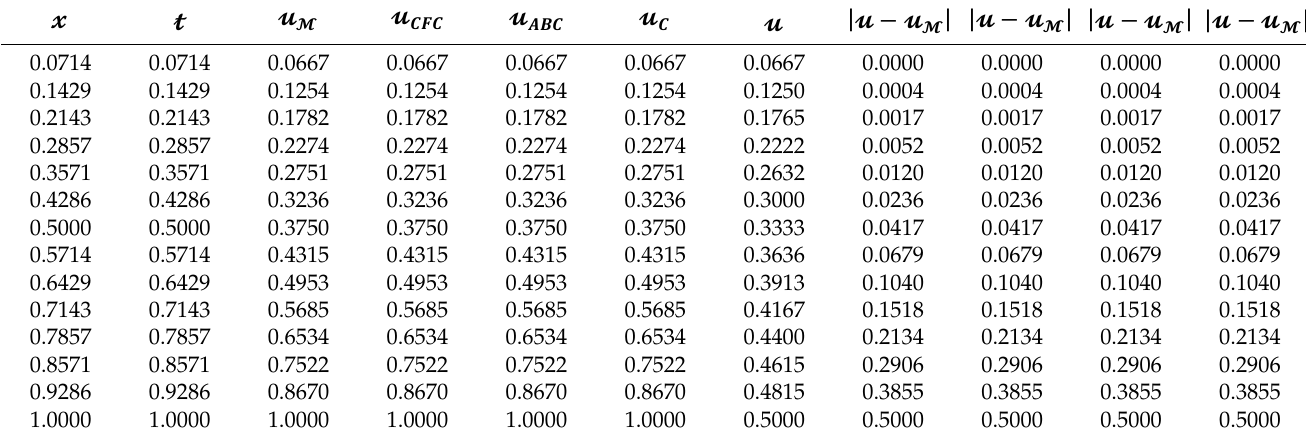
Table 2. The values of the approximate and exact solutions at 𝛼 = 1 and absolute error of Equa- tions (55), (59), (62), (64) and (66) at different values of 𝓉, 𝓍 .